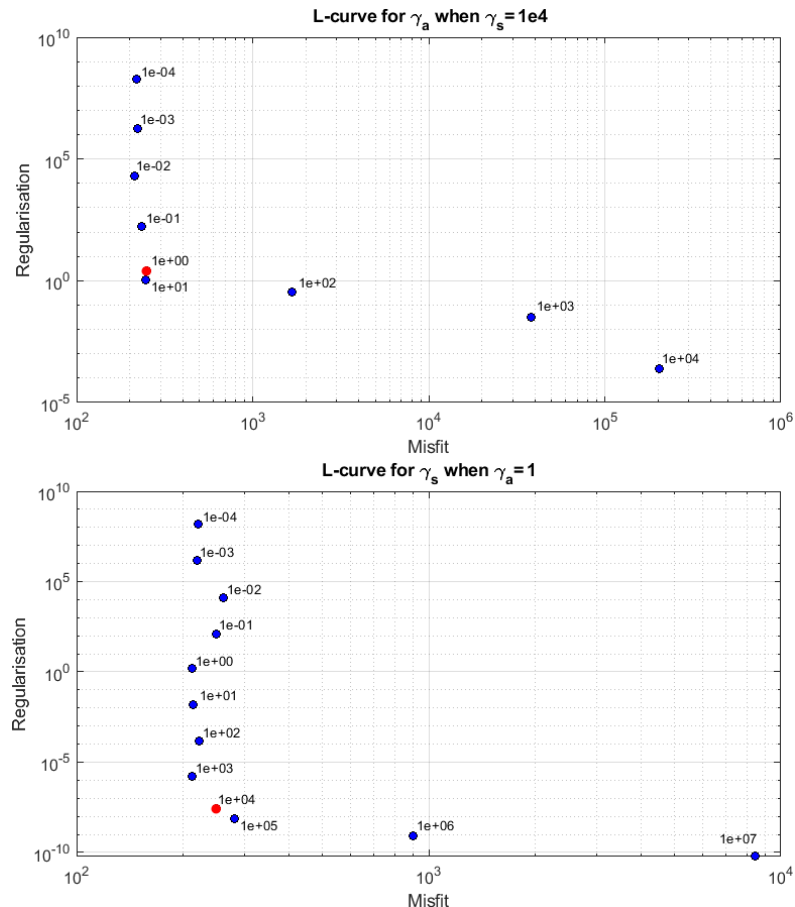
Figure A1. L -curves for Úa. Points are labelled with values of γ a and γ s , and the chosen values are indicated in